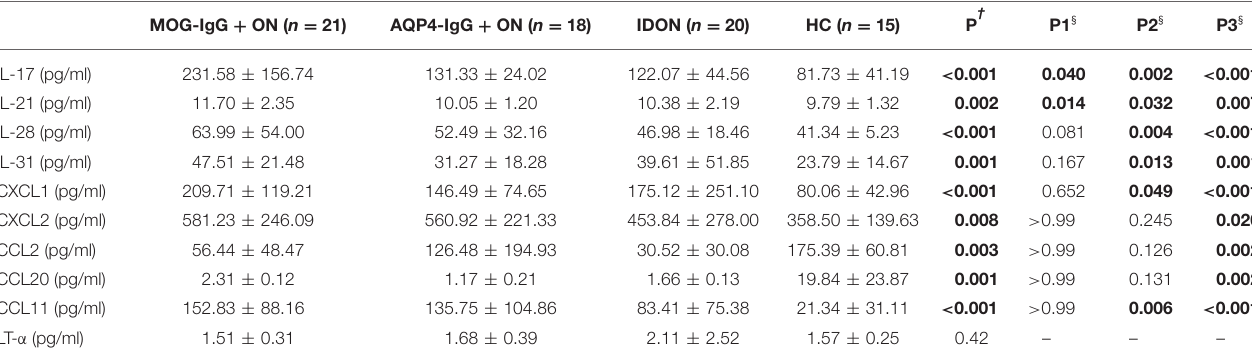
TABLE 2 | Serum level of Th17-related cytokine/chemokines of optic neuritis patients. MOG-IgG + ON ( n =